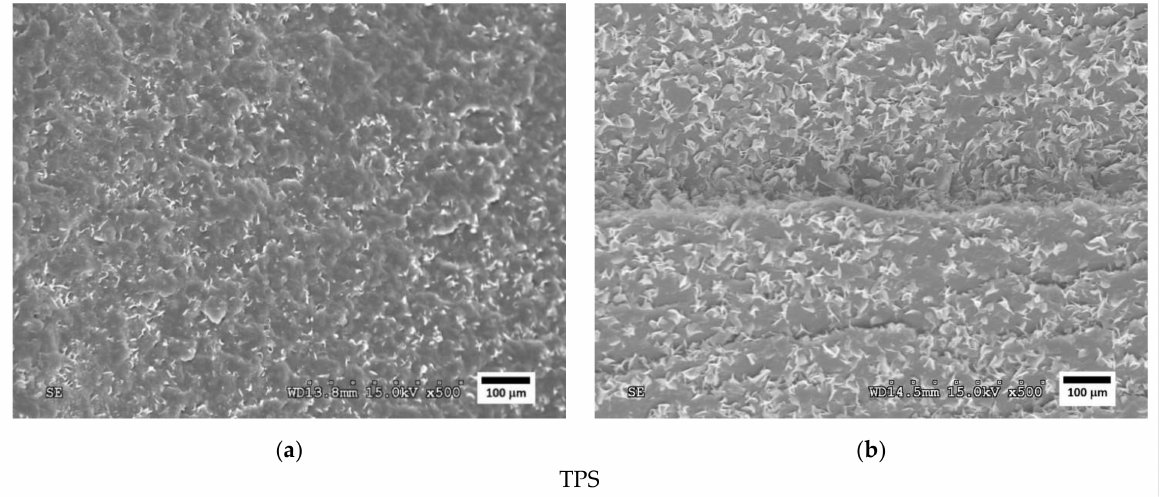
Figure 6. SEM micrographs of fractured surfaces at 500 × of ( a ) TPS80PBS20 and ( b ) TPS60PBS40 blends.